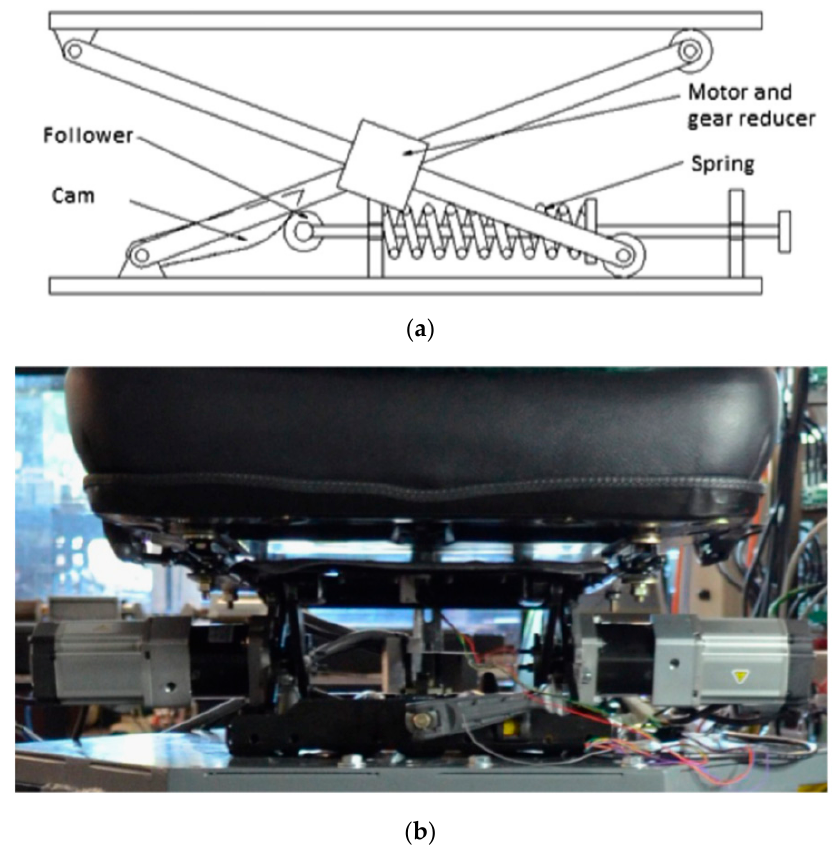
Figure 12. (a) The schematic of the seat structure (b) Front view of the seat structure [58]. Figure 12. ( a ) The schematic of the seat structure ( b ) Front view of the seat structure